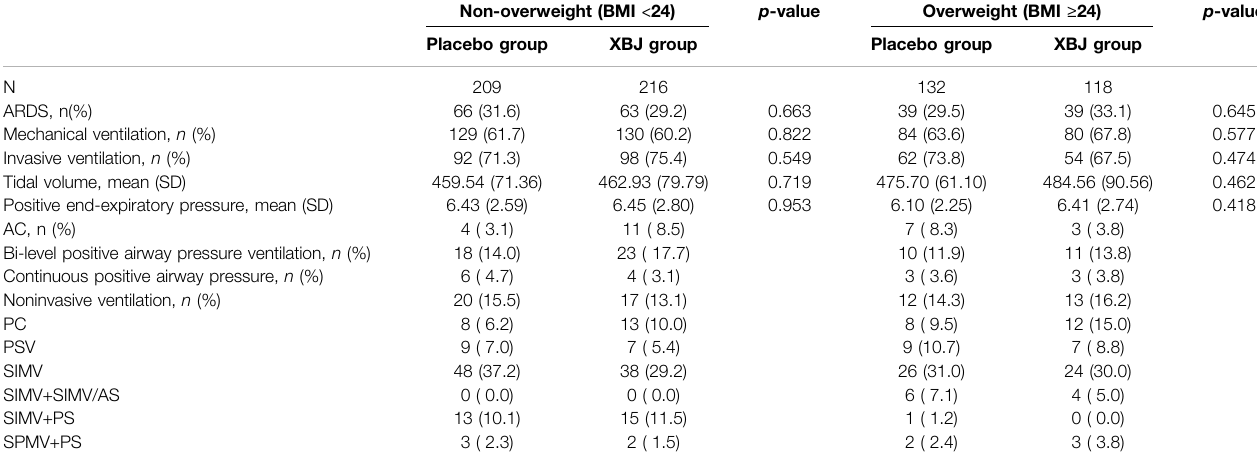
TABLE 3 | Rate of patients with ARDS and the baseline settings of mechanical ventilation in the BMI